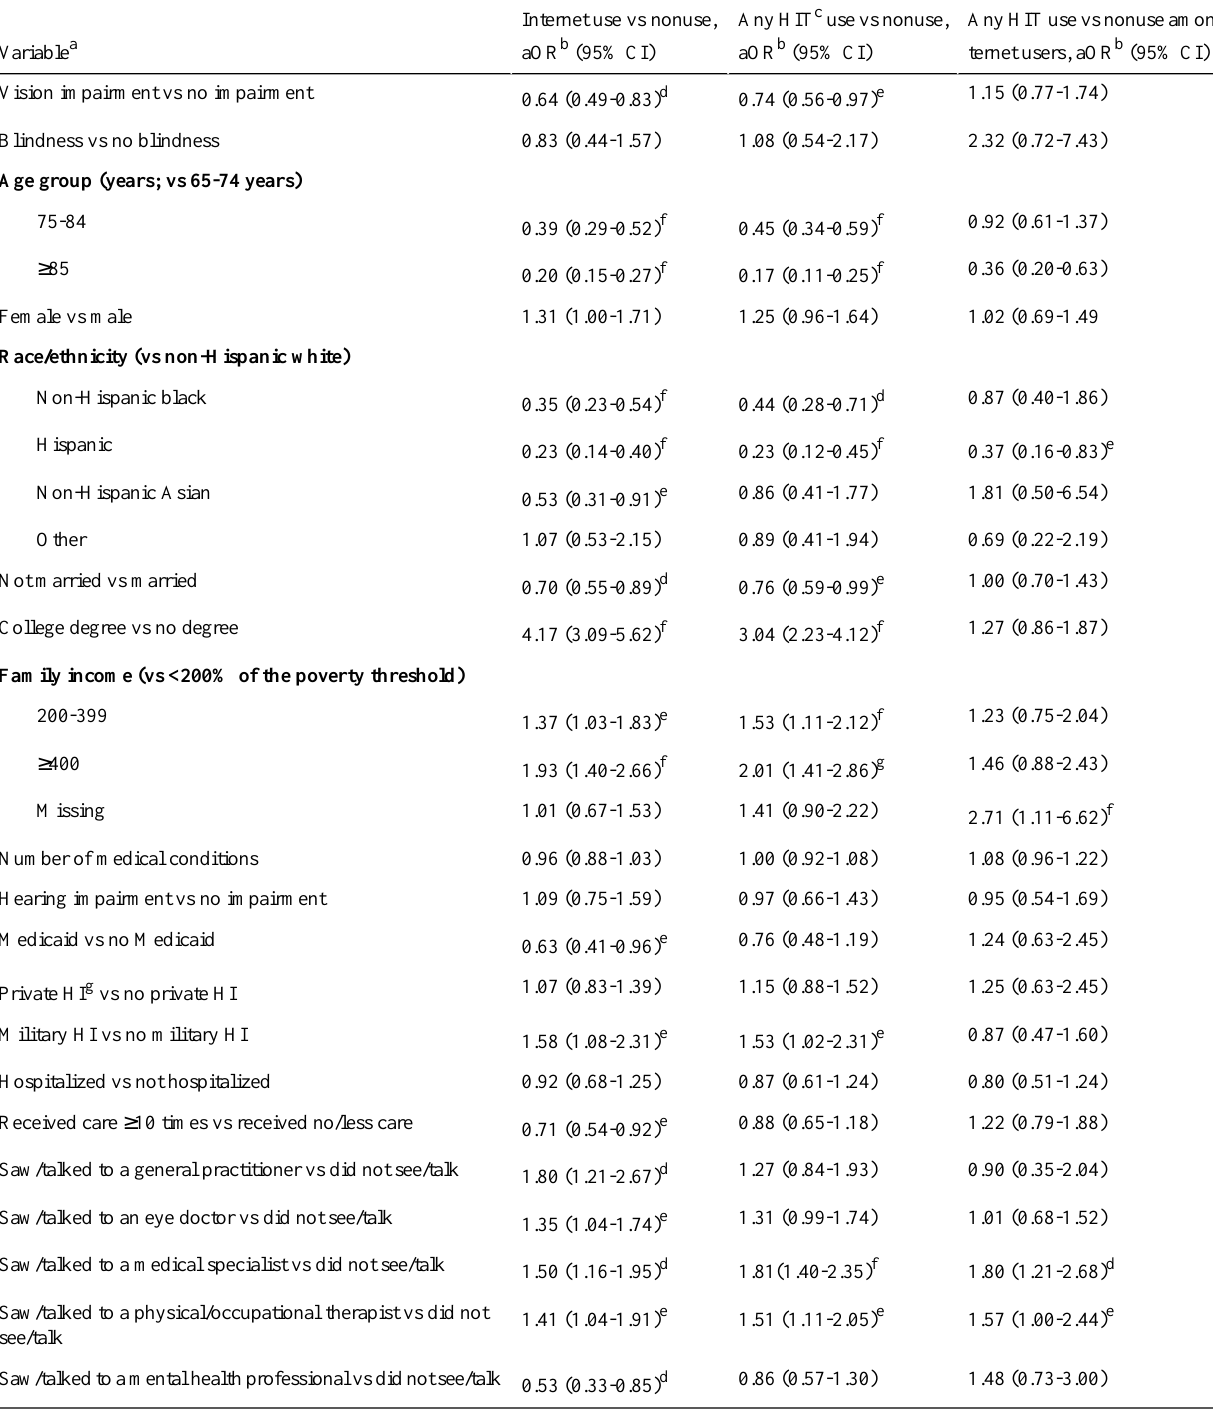
Table 3. Association of vision impairment with internet use and any health information technology use: logistic regression